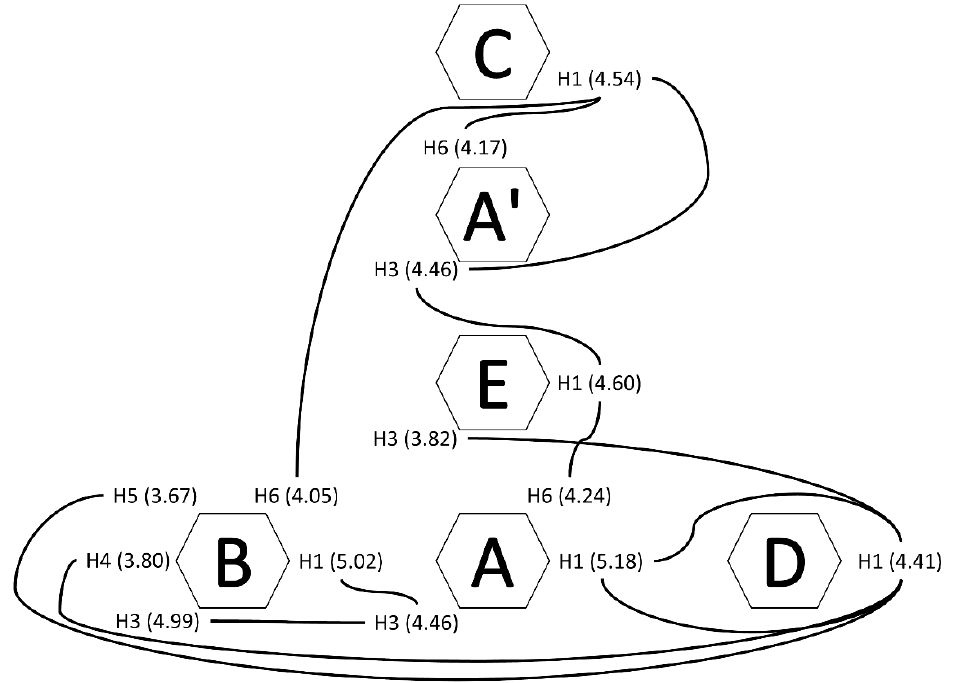
Figure 7. Inter ‐ residue correlations from NOESY spectrum. Figure 7. Inter-residue correlations from NOESY